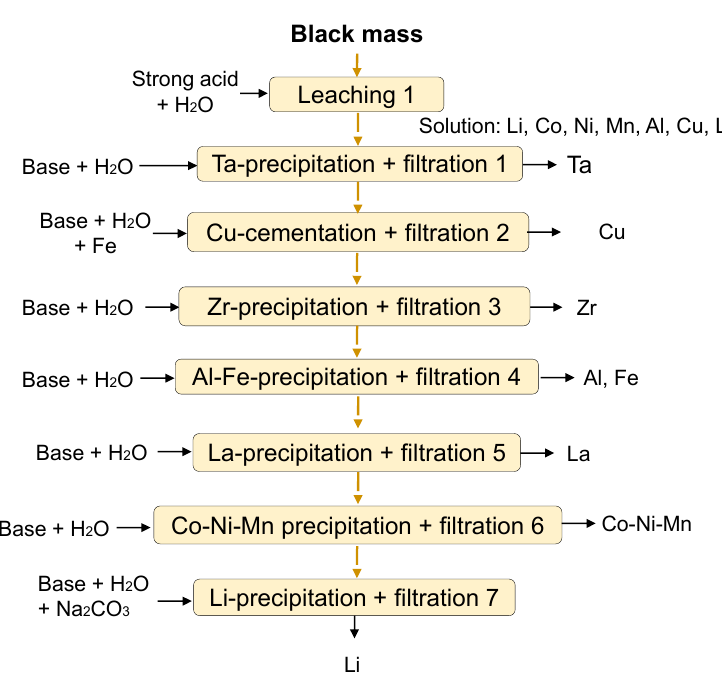
Figure 11. Developed recycling path for multi-step hydrometallurgy (Scenario 1: Full dissolution of garnet structure → aggressive leaching).